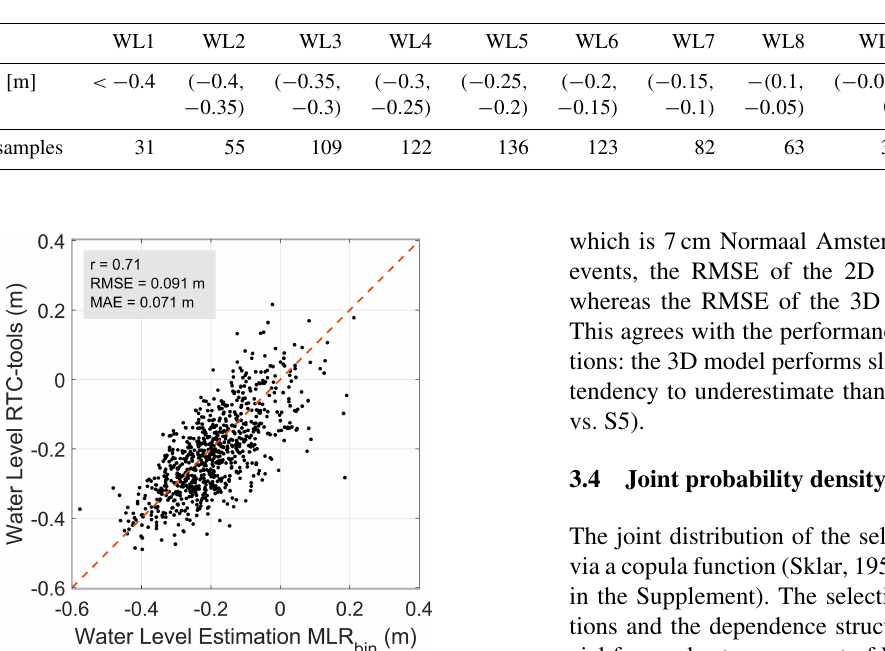
Figure 3. Density histograms for precipitation (a) , SWL (b) , and low tide (c) associated with all hourly time series (blue), with selected predictors (conditioned to WL max ) (pink), and with the corresponding univariate annual maxima (green). Table 2. Distribution of the bin-sampling classes.